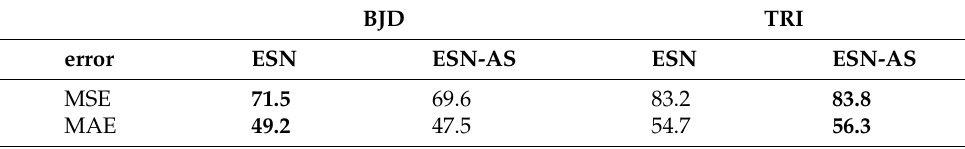
Table 8. Gains (%) over Persistence—TRI and BJD.